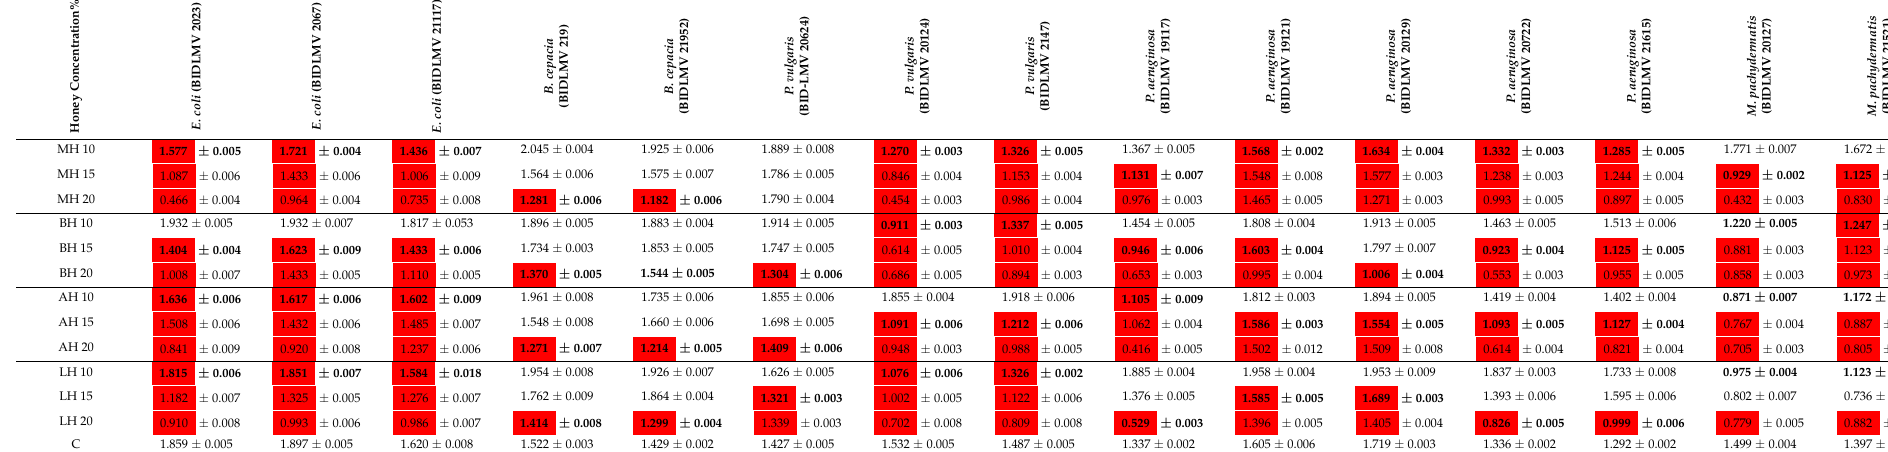
Table 2. The OD values of honey samples tested on the isolated